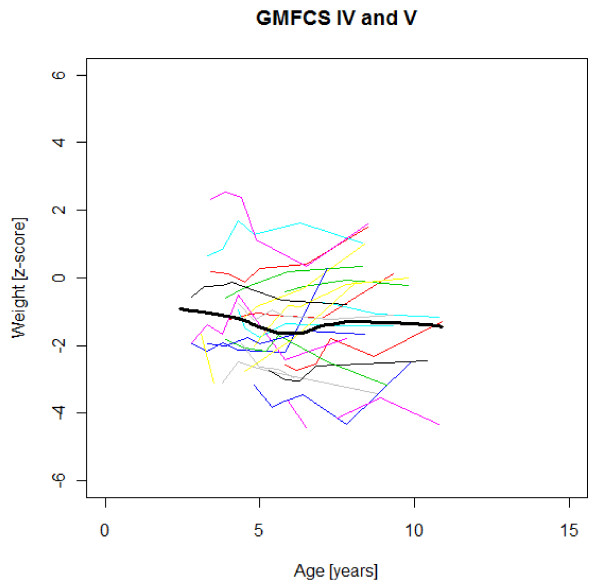
Weight z-scores in GMFCS IV-V. Weight z-score at different age in 24 children with CP spastic diplegia, GMFCS IV-V. Their mean z-score development with age is shown in black.